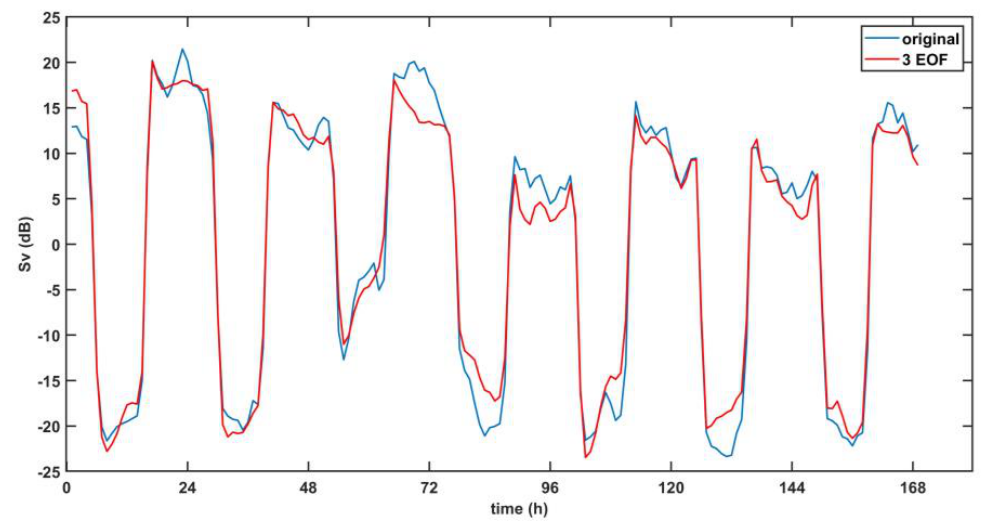
Figure 6. A subsample of 7 days of signal reconstructed with the first three EOF modes compared with the correspondent original data. Both time series are mean-detrended. Time series is at 200 m depth.